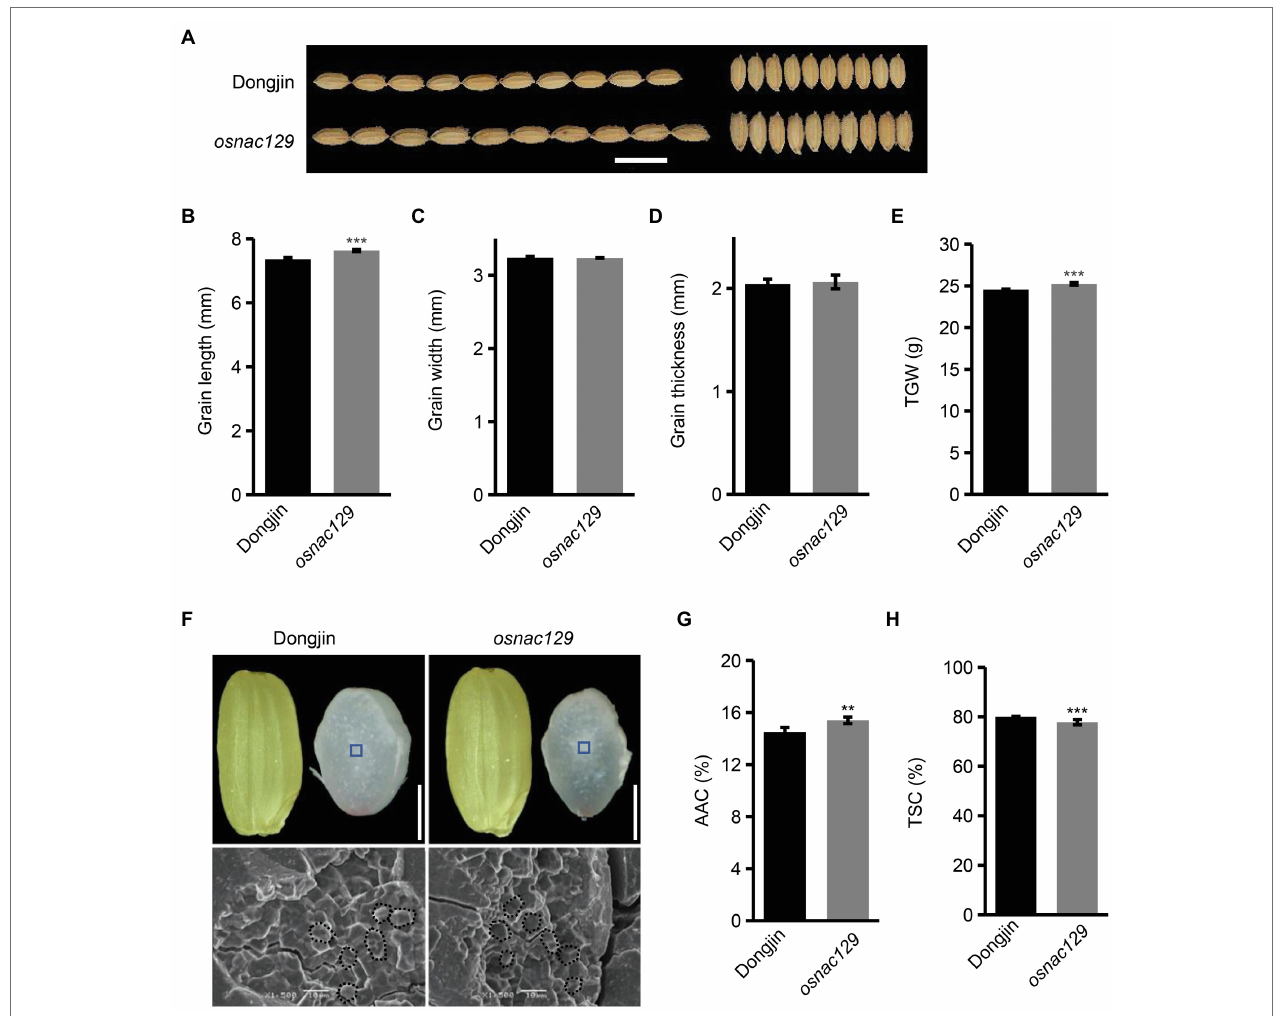
FIGURE 2 | The osnac129 mutant has increased grain size and apparent amylose content. (A) Phenotypic observation of osnac129 grain at maturity. Scale bar = 10 mm. (B–E) Show the grain length, grain width, grain thickness, and 1,000-grain weight (TGW) of mature seeds, respectively. Data are means ± SD of three replicates. (F) Brown rice grains and cross sections of grains (upper panel, scale bars = 2.5 mm), and electron micrographs of starch granules (lower panel, scale bars = 10 μ m) from the wild-type (WT) and osnac129 mutant. Blue boxes in the upper panels indicate the central area of the mature endosperm, where starch granules were analyzed by scanning electron microscope (SEM), and areas in the bottom panels delineated by dotted lines indicate starch grains. (G,H) Show the apparent amylose content (AAC) and total starch content (TSC) of grains from the WT and osnac129 mutant, respectively. Data are means ± SD of five replicates. ** p < 0.01, *** p < 0.001 as determined by Student’s t